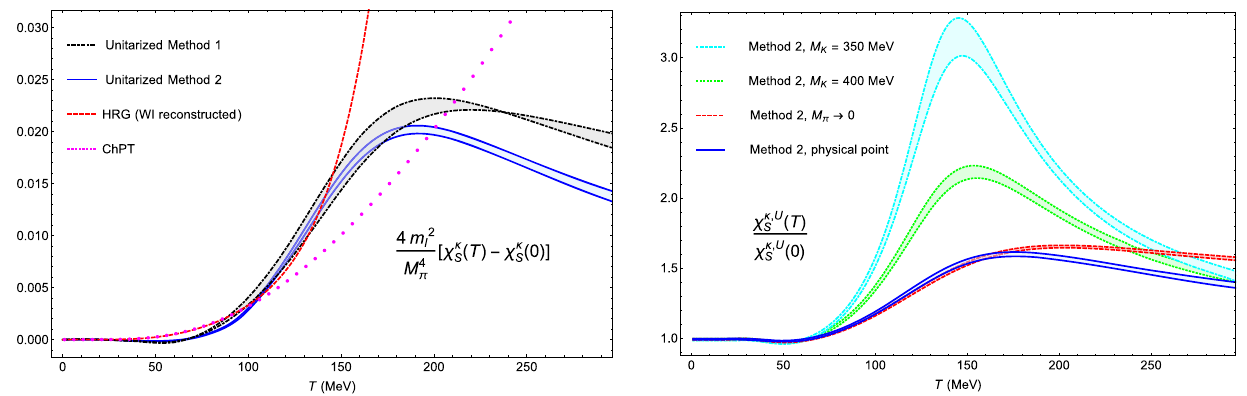
Fig. 3 Left panel: κ susceptibility from UChPT with the two methods explainedinthe maintext,including theirtheoreticaluncertaintybands, the perturbative ChPT result and the HRG one extracted from the quark